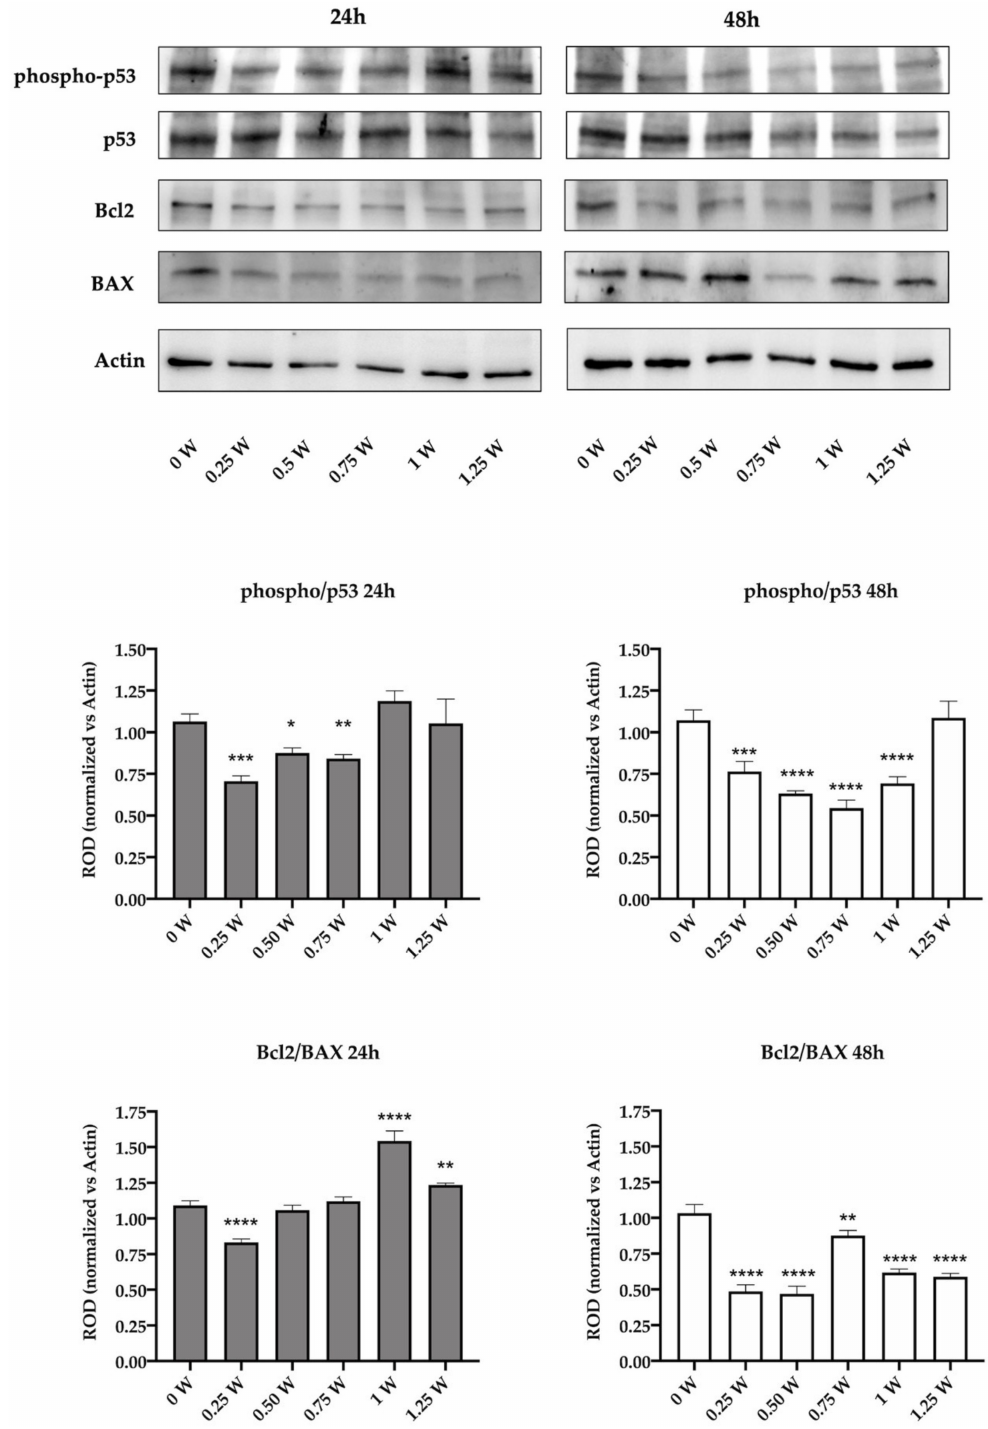
Figure 6. Effect of 808-nm laser irradiation on p53 activation and the Bcl2/Bax ratio. The upper part of the figure shows the western blot (WB) signals of the expression of phospho-p53, p53, Bcl2, and Bax in the OHSU-974 FAcorr 24 or 48 h after treatment with the 808-nm laser at powers ranging from 0 to 1.25 W. The graphs below show the ratio between the expression of phospho-p53 (active form) and p53 and the ratio between Bcl2 and Bax (anti-apoptotic/pro-apoptotic). WB signals are representative of at least three independent experiments. For the graphs, data are reported as mean ± SD, and each graph is representative of at least three independent experiments. Statistical significance was tested by a one-way ANOVA. *, **, ***, and **** represent a p < 0.05, 0.01, 0.001, and 0.0001, respectively, between the treated sample and the untreated sample (0 W) used as control, at the same time after